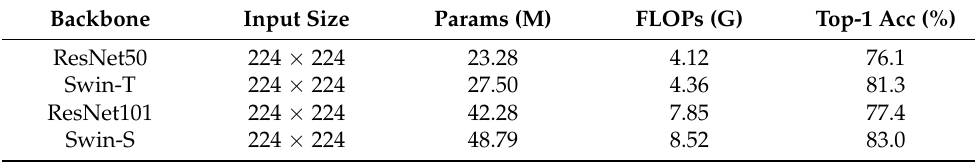
Table 3. Comparison of the Swin transformer backbone with the ResNet backbone.